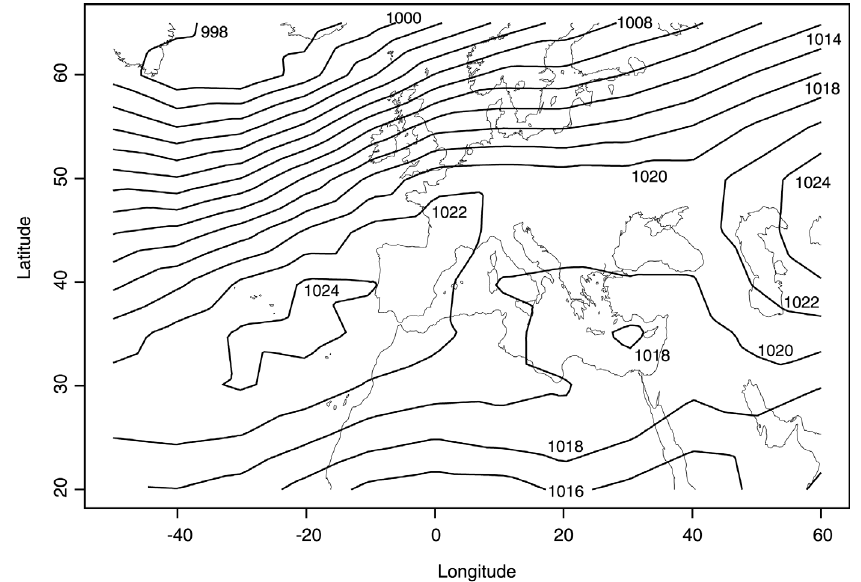
Fig. 5b. The mean winter pressure map associated with the six lowest canonical function years (precipitation in the east, dry in the west). All contours labelled in